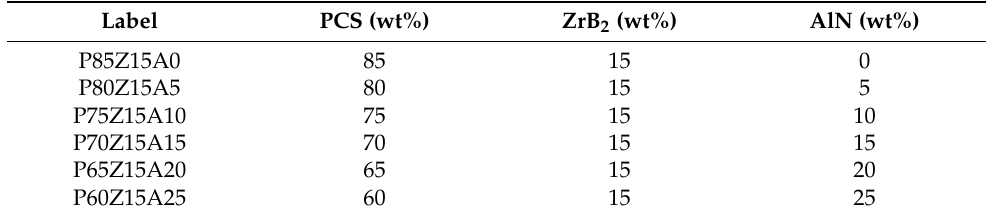
Table 1. Starting compositions of different